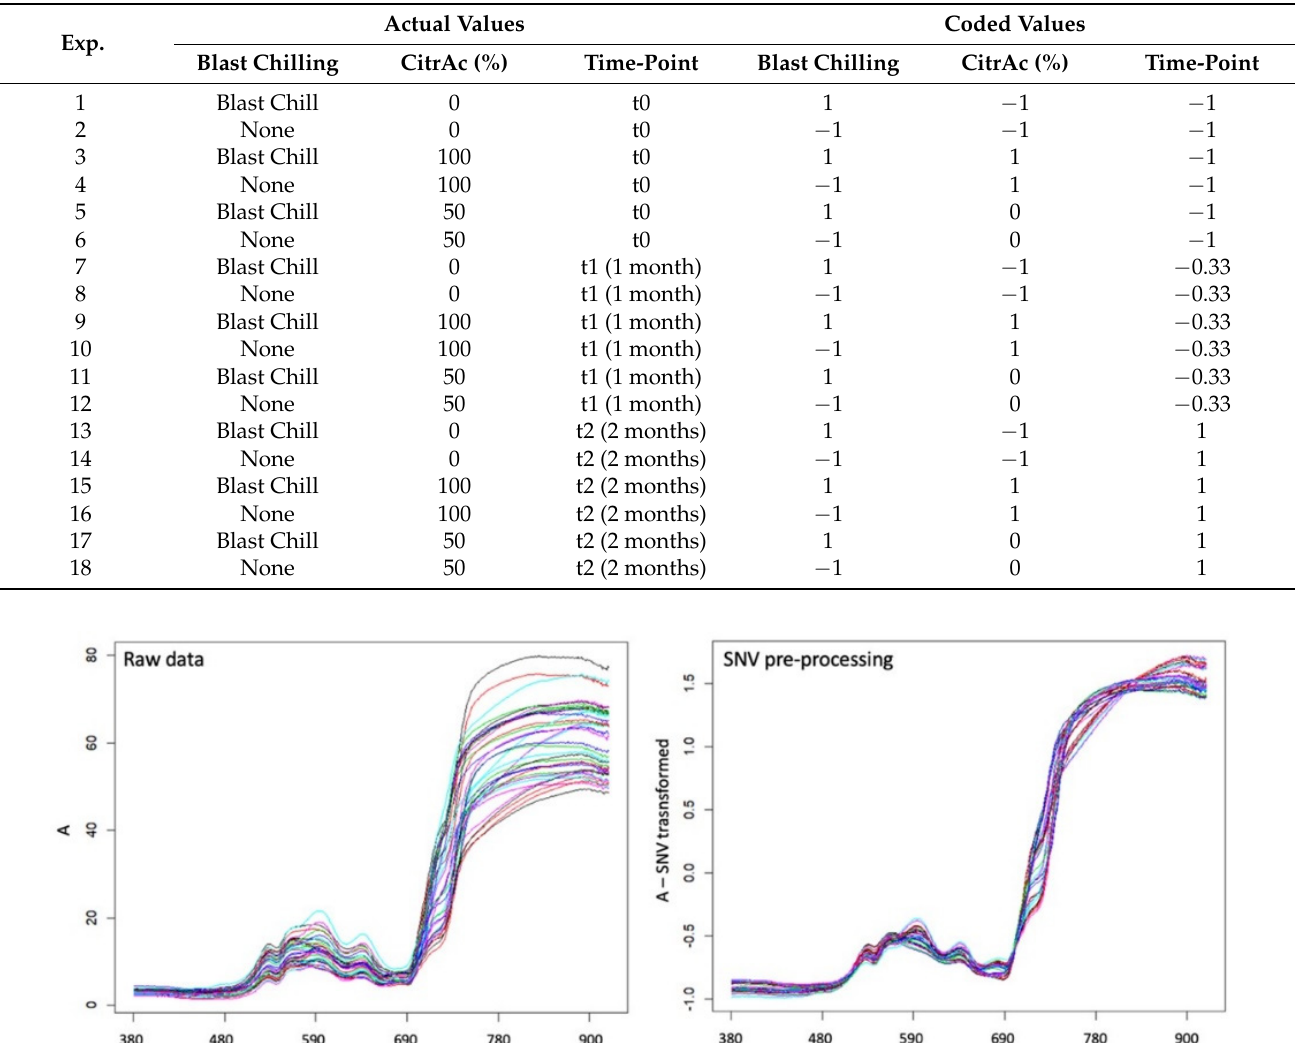
Table 2. Experimental plan in the standard order.